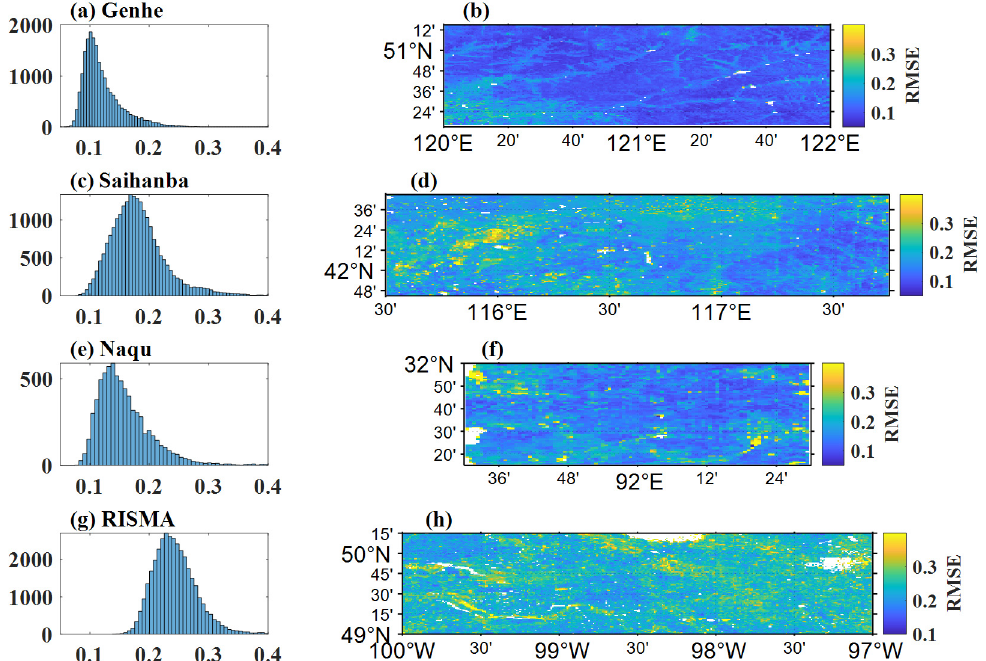
Figure 16. The histogram and spatial distribution of the root mean square error (RMSE) between SSI new and SSI S1 of the nonlinear regression model shown in Equation (11) over the Genhe watershed ( a , b ), Saihanba ( c , d ), Naqu ( e , f ), and RISMA ( g , h ) areas.